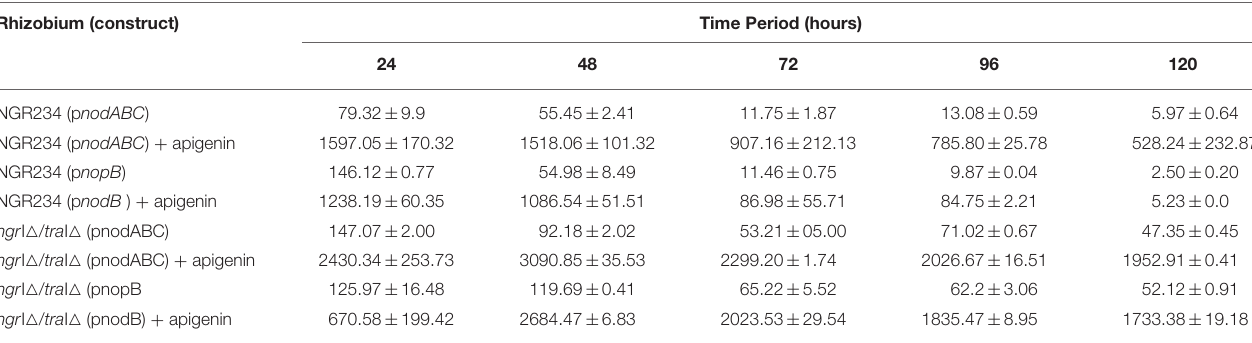
TABLE 5 | β -galactosidase activities of NGR234 and NGR234- △ traI- △ ngrI carrying either a nodABC::lacZ or a nopB::lacZ promoter fusion and in response to apigenin. Rhizobium (construct)